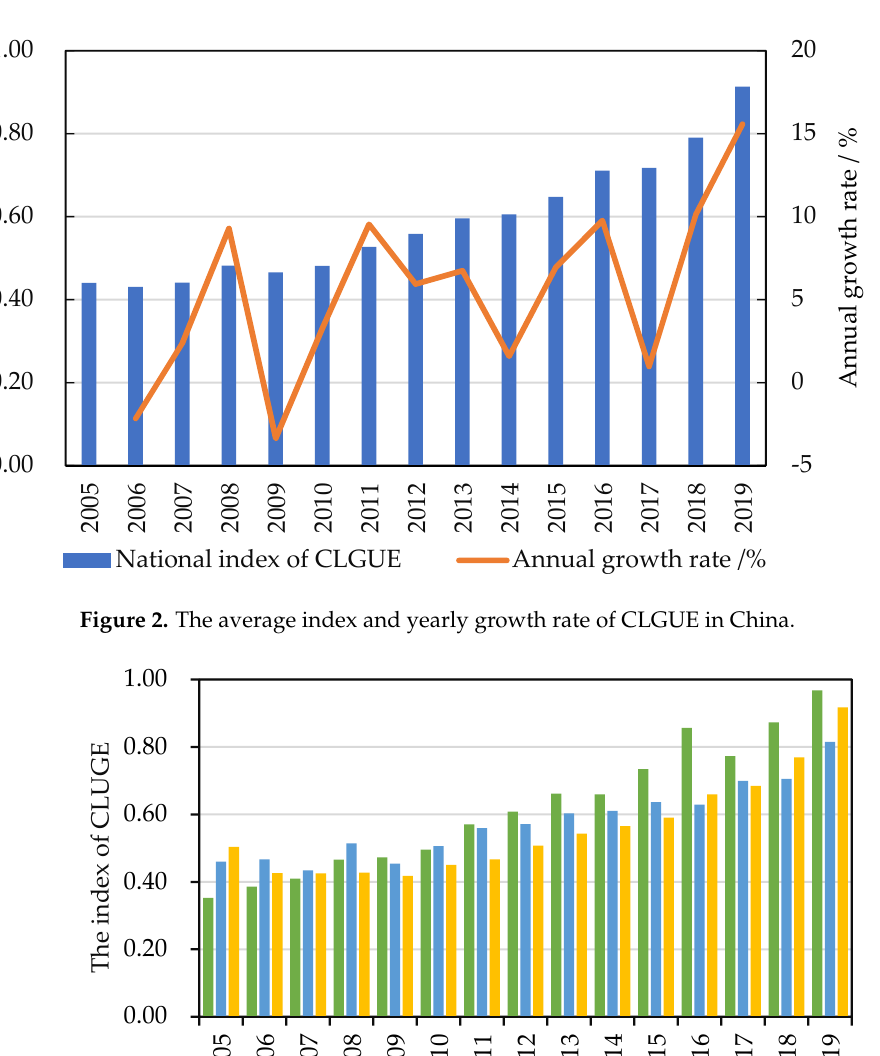
Figure 2. The average index and yearly growth rate of CLGUE in China.